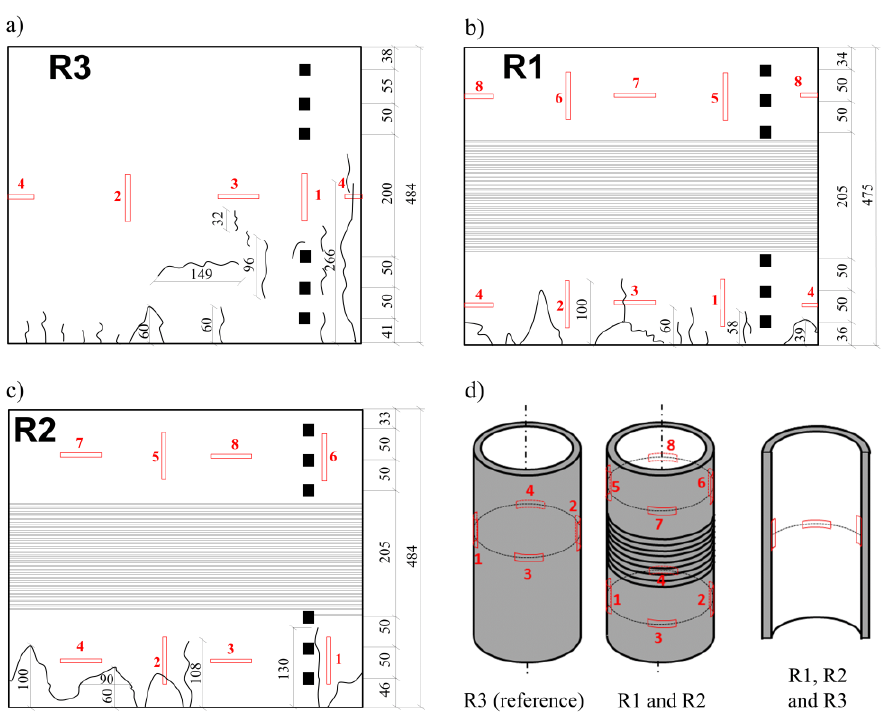
Figure 6. Layout of cracks and failures on the external surface of ( a ) hollow cylinder R3, ( b ) hollow cylinder R1 and ( c ) hollow cylinder R2. The positions of the electrofusion strain gauges are also indicated ( d ).